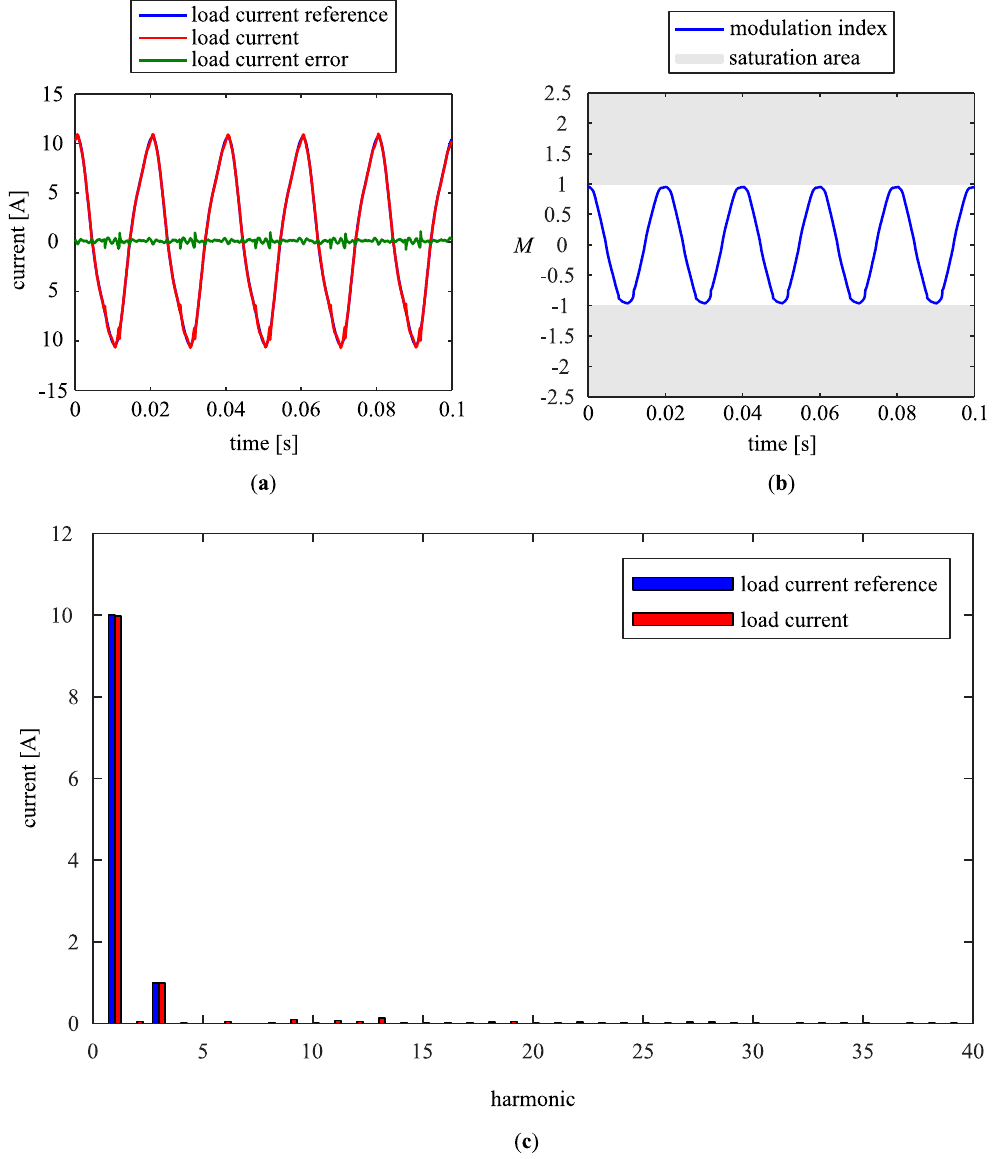
Figure 7. Power converter operating below the saturation level V S max ; ( a ) Load current reference i* (containing fundamental harmonic with amplitude of 10 A and the third harmonic with amplitude of 1 A), load current i and load current error ε ; ( b ) modulation index M; ( c ) frequency spectra of load current reference i* and load current i